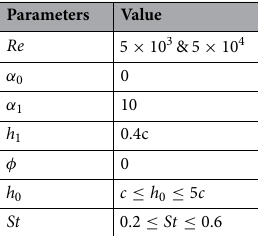
Table 3. Selective parameters for present study.